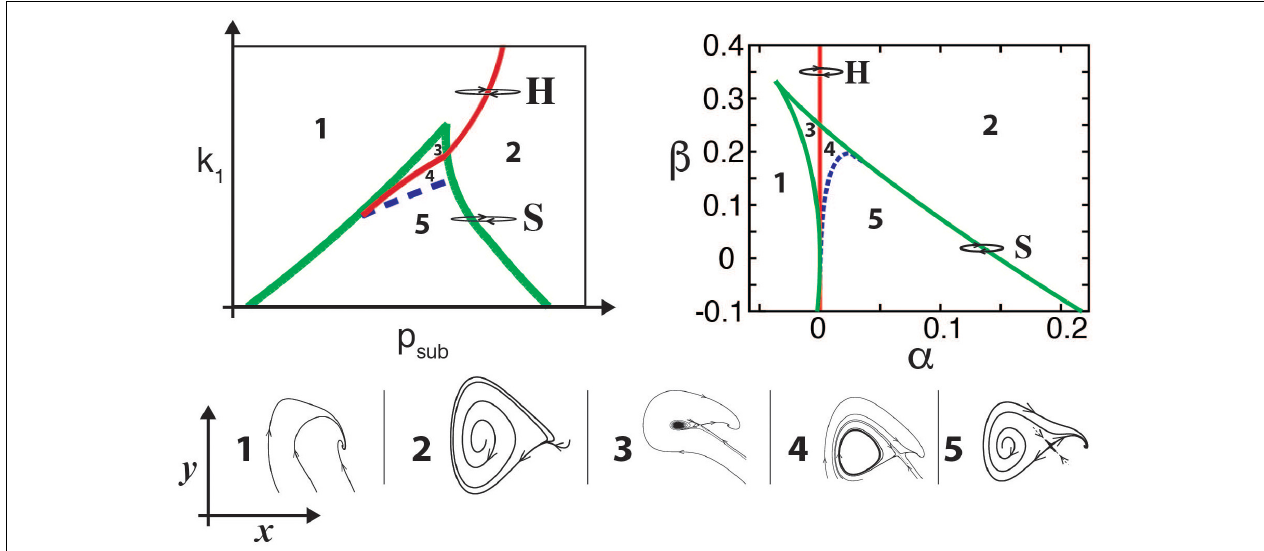
FIGURE 2 | Bifurcation diagrams of birdsong production models. For the physical model (upper left panel), the diagram is displayed in the ( p sub , k 1 ) parameter space, representing the subglottal pressure and the labial tension, respectively. The bifurcation diagram of the normal form (upper right panel) is displayed in the ( α , β ) parameter space. Typical portraits of the ( x , y ) phase spaces for each region are shown in the corresponding numbered lower insets, showing the different dynamical regimes that occur in each region separated by bifurcation lines. In both upper panels, continuous red line represents a Hopf bifurcation, dashed blue line the homoclinic bifurcation, and green lines the saddle-node bifurcations. Paths H and S in the parameter space represent different ways to start oscillations of the labia, either by crossing the Hopf (H) or the saddle-node in limit cycle (S) bifurcation lines, thus generating either tonal or spectrally rich sounds. Adapted from Sitt et al.